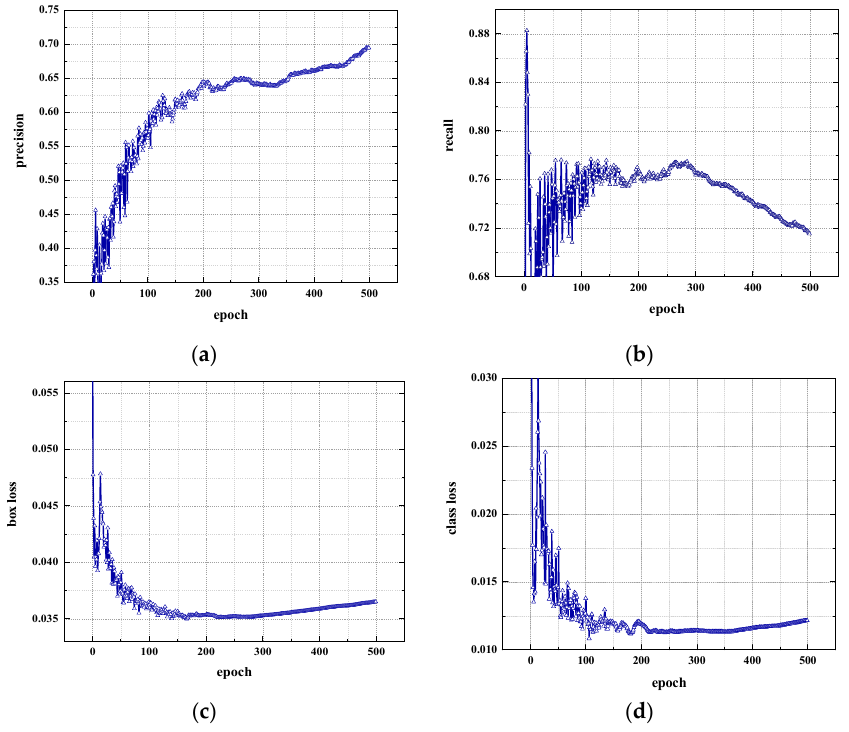
Figure 3. Training result. ( a ) precision; ( b ) recall; ( c ) box loss; ( d ) class loss.